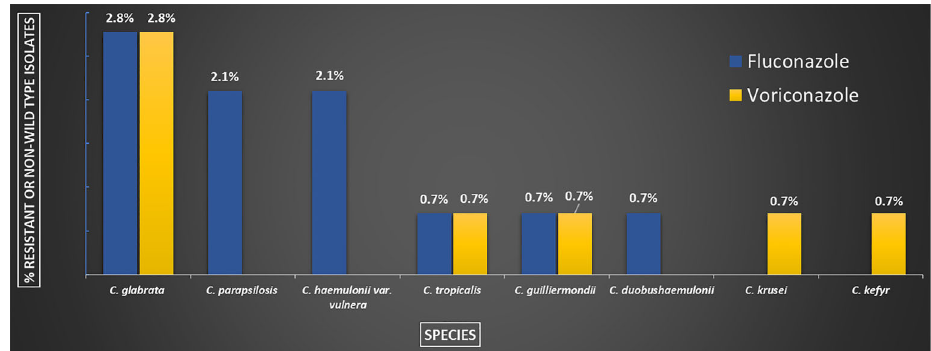
Figure 1. Percentage of fl uconazole (n=13) and voriconazole (n=8) resistant, non-wild type or with high minimum inhibitory concentrations for 144 bloodstream Candida isolates, from hospitals in São Paulo, Brazil (2017 –